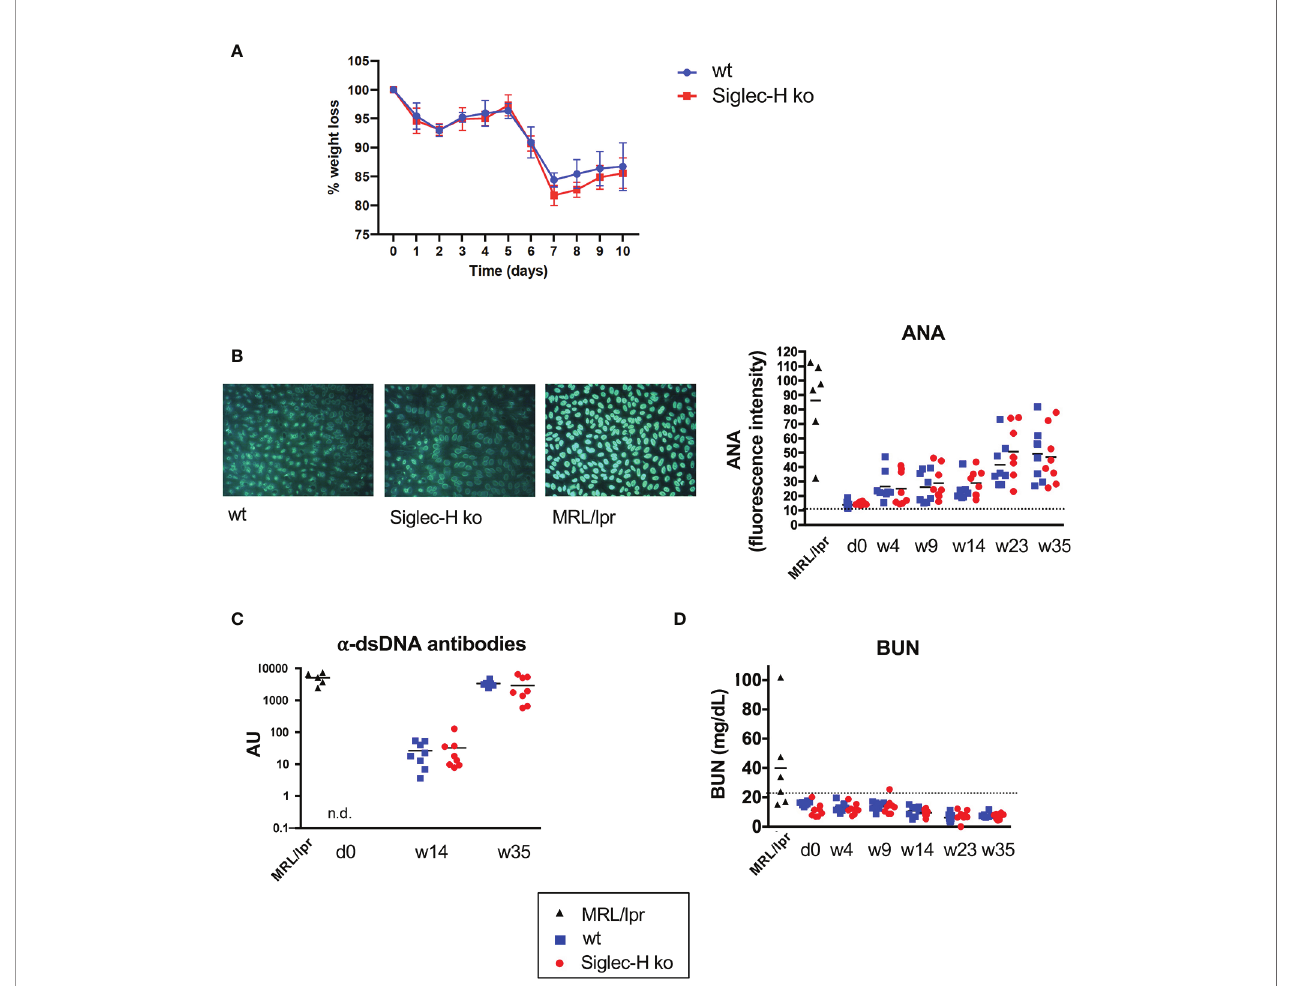
FIGURE 3 | After LCMV clone 13 infection Siglec-H ko mice show less weight loss and no increased autoantibody levels compared to wt mice. Mice were infected with LCMV clone 13 virus (5 x 10 6 pfu). (A) Weight loss of wt and Siglec-H ko mice over 10 days of LCMV infection. (B) Sera of LCMV-infected mice were semi- quantitatively analysed on HEp-2 slides for ANA antibodies. On the left example pictures from HEp-2 stainings of week 35 are shown. The mean pixel intensity was determined from 10 randomly analysed cells per sample and is shown on the right. Each symbol represents the IgG serum ANA level of a single mouse. (C) Anti- dsDNA antibodies in sera of LCMV-infected mice were measured by ELISA. Each symbol represents a single mouse. AU, arbitrary units. (D) Urea nitrogen contents in the blood of in fl uenza-infected or LCMV-infected mice were determined with an enzymatic BUN kit. Representative of two experiments (n = 8 mice and n = 5 MRL/lpr mice). Sera of MRL/lpr mice served as a positive